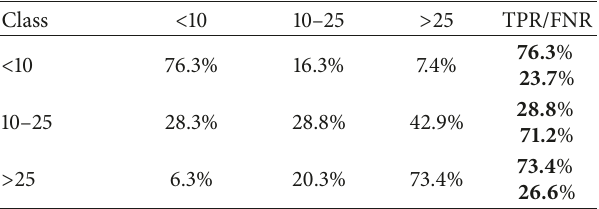
Table 4: Confusion matrix of three-class classification for Cotocol- laousingaRBT.Rowsrepresentthetrueclassandcolumnsrepresent the predicted